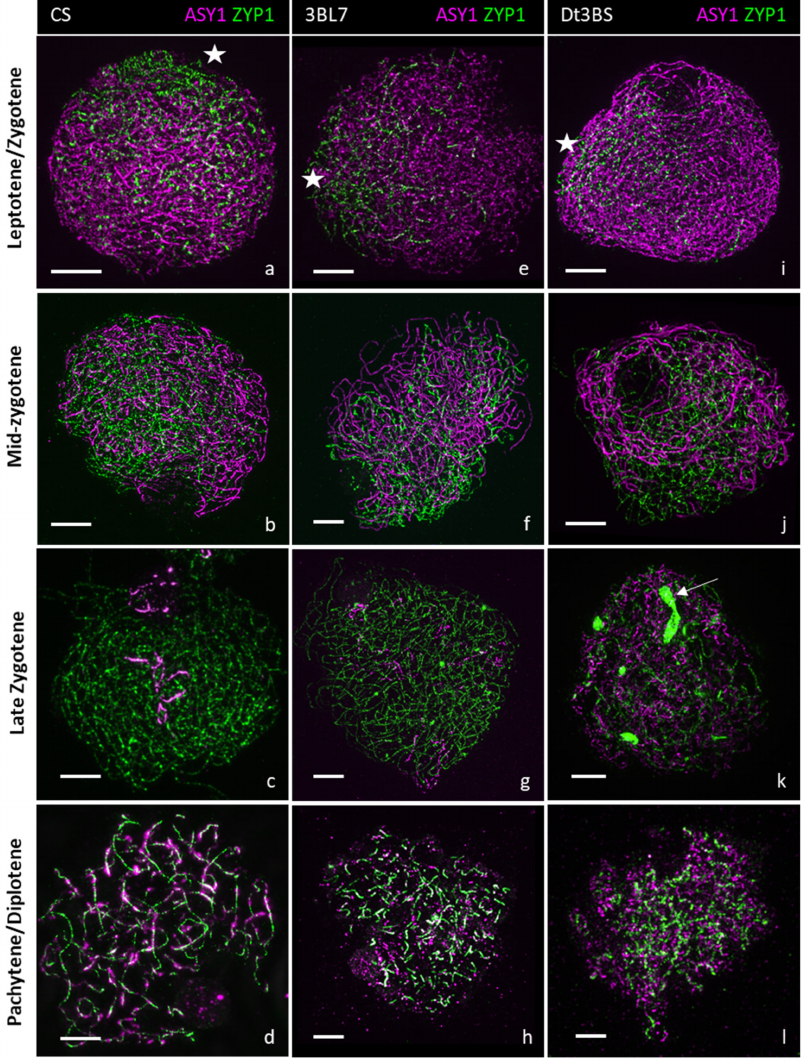
Figure 3. Comparison of synapsis in CS, 3BL7 and Dt3BS by 3D super resolution imaging. Chro- mosomes axes are labelled with ASY1 (magenta), and ZYP1 (green) is used to follow synapsis. In CS ( a – d ), synapsis starts at one side of the nucleus (white star; a ) and progressively brings the homologues together at zygotene ( b , c ). Chromosomes are fully synapsed at the pachytene/diplotene stage ( d ). In 3BL7 ( e – h ), synapsis resembled that of the wild type of CS. In Dt3BS, the initiation of synapsis ( i ) and the progression at zygotene ( j ) are similar to CS. However, during zygotene, ZYP1 forms polycomplexes (white arrow; k ) during synapsis, suggesting a difficulty to polymerize the central element of the synaptonemal complex, although chromosomes seem aligned with a dotty synapsis at pachytene ( l ). Scale bar = 5 µ